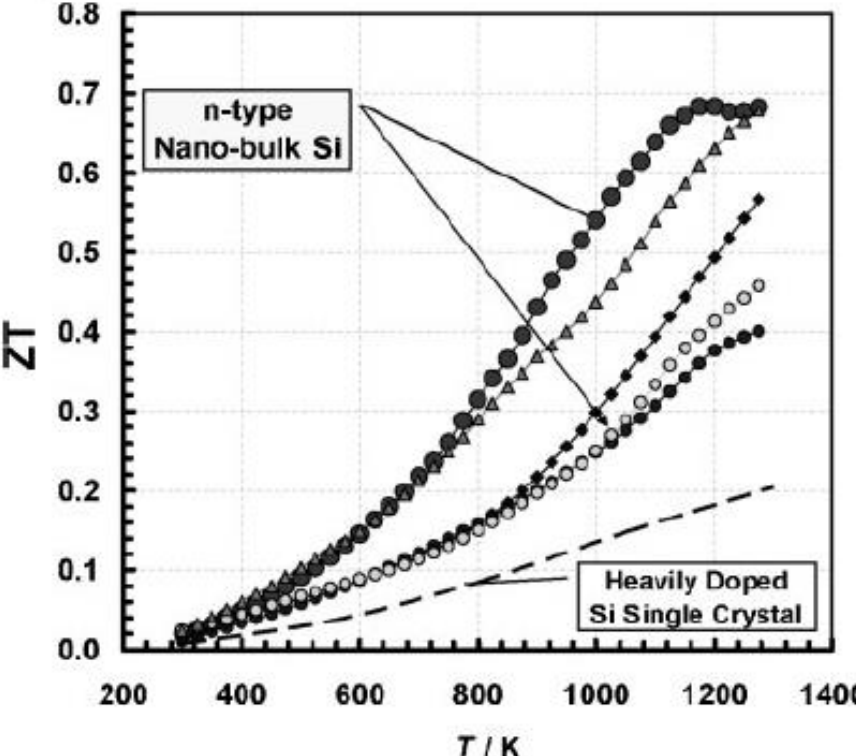
Figure 1. Comparison between ZT values for heavily doped single-crystalline Si (dashed lines) and nanostructured n-type silicon (n-type Nano-bulk Si) (Circles) as a function of temperature. Reprint with permission [5318650473494]; Copyright Year 2022, John Wiley and Sons Publisher [9]. From another perspective, nanostructured silicon in different forms has been studied as an effective thermoelectric material by many researchers in a wide range of different porosities [7,10,18]. For instance, Ting Zhang et al. presented a remarkable enhancement in the ZT values due to texturing the front and back sides of Si substrate performing Si nanowire arrays (SiNWAs). The structure of the modified device is SiNWAs/Si/SNWAs sandwich structured composites (SSC) [18]. ZT values were remarkably increased from 0.006 for bulk Si devices to 0.493 for the modified SSC at room temperature. Figure 2a shows a schematic representation of the fabricated SSC and the measuring unit. Furthermore, Figure 2b shows the effect of mean pore diameter (MPD) on the electrical resistivity ( ρ ssc) and the ZT values of the performed SSC thermoelectric devices. The increase in the pore diameter leads to an increase in the electrical resistivity due to performing the nanopores in the heavily doped Si regions. Moreover, the thermoelectric properties were found to improve with increasing the pore diameter due to the increase in the surface-to-volume ratio, which leads to increasing the mean free path for phonon